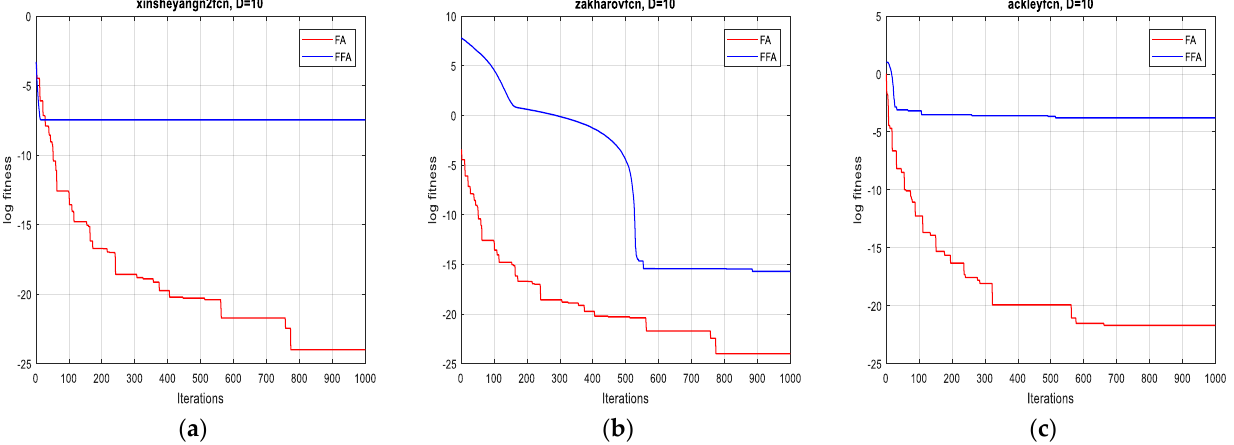
( c ) Figure 4. Convergence curves of FFA and FA for the functions: ( a ) F10; ( b ) F11 and ( c ) F12 (30D). As can be seen from Table 3, the proposed algorithm is more unbiased (the statistical expected value of obtained cost function of FFA is more tending to the theoretical value than FA) and more consistent (the standard deviation of obtained cost function when ap- plying FFA is more tending to 0 than the FA). The reported remarks hold for the twelve test functions as previously shown in Table 3 for dimensions 2D, 10D, 20D and 30D, re- spectively. For more convincing, robustness and stability of FFA in higher dimensions are evaluated by using the test functions (F13, F14 and F15) for dimensions 50D, 100D, 150D and 200D, respectively. Table 4 gives the results of these tests with a 10 times run for each test function. Finally, it can be concluded that the stability of FFA is not affected by in- creasing significantly dimensions (high precision remains obtained). The graphs of Figure 5 reflect these results.